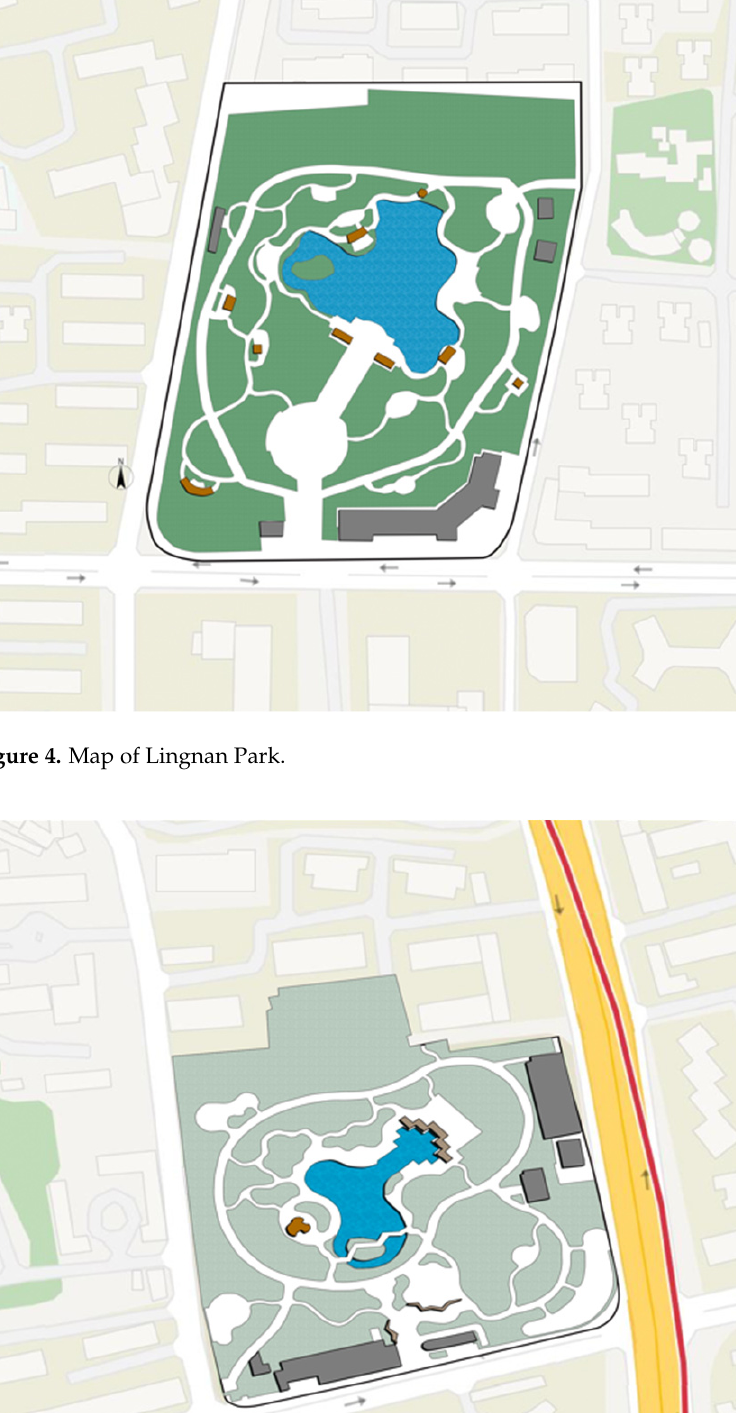
Figure 3. Map of Pengpu Park.